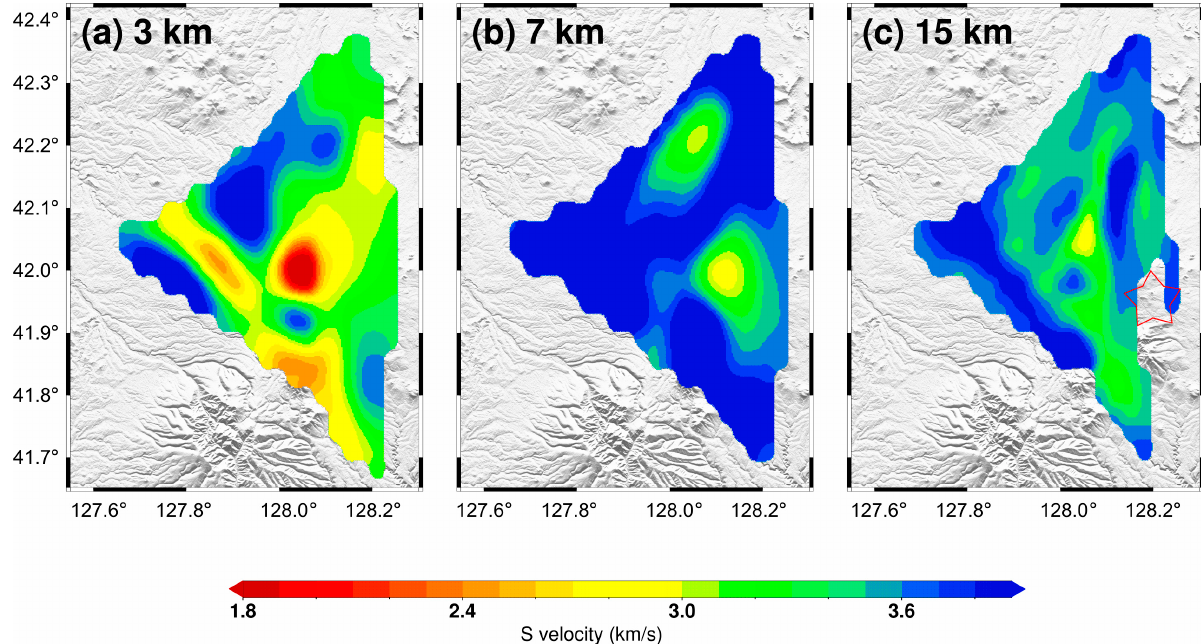
Figure 2. The original ambient noise tomography results for different depths.